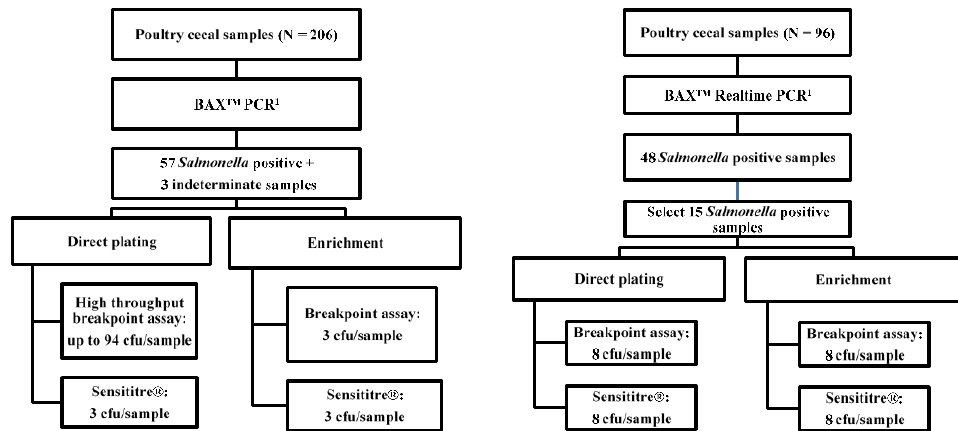
Figure 1. Workflows of trial 1 ( left ) and trial 2 ( right ). 1 Cecum samples in trial one were screened for Salmonella presumptive samples using an endpoint assay (BAX TM Salmonella 2 PCR Assay, KIT2012, Hygiena LLC), and cecum samples in trial two were screened via a real-time PCR assay (BAX TM Salmonella Real-time PCR Assay, KIT2006, Hygiena